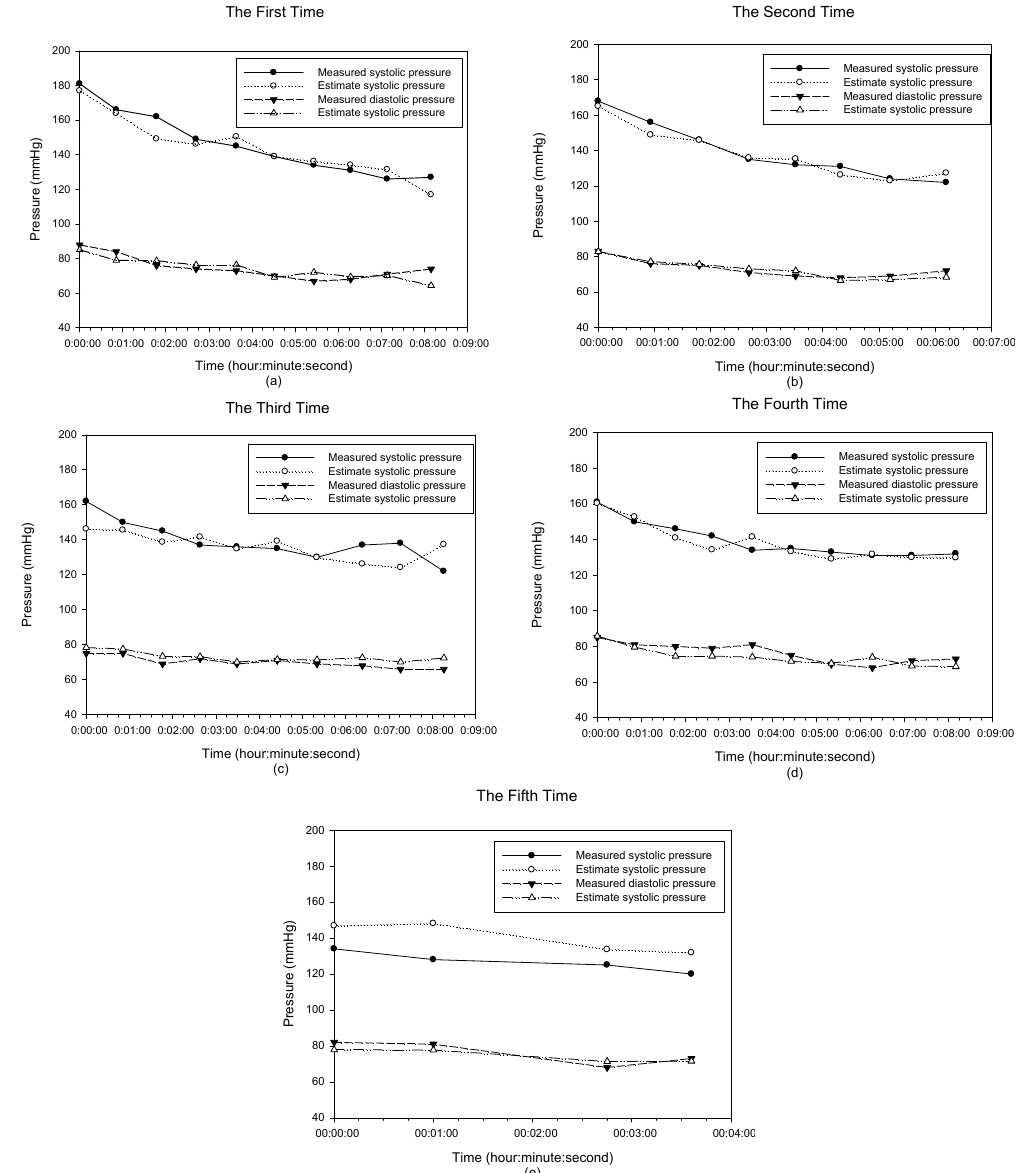
Figure 5. The measured and estimated blood pressures during five exercises for the fifth subject. ( a ) the first time experiment, ( b ) the second time experiment, ( c ) the third time experiment, ( d ) the fourth time experiment, ( e ) the fifth time experiment.